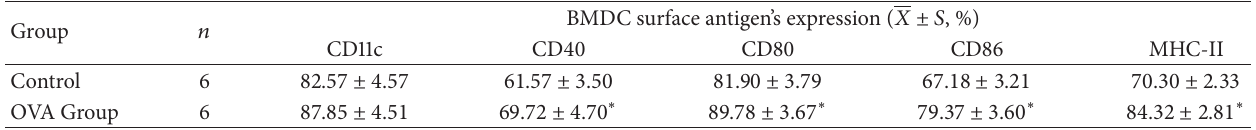
Table 1: BMDC surface antigen’s expression of OVA group compared with control.